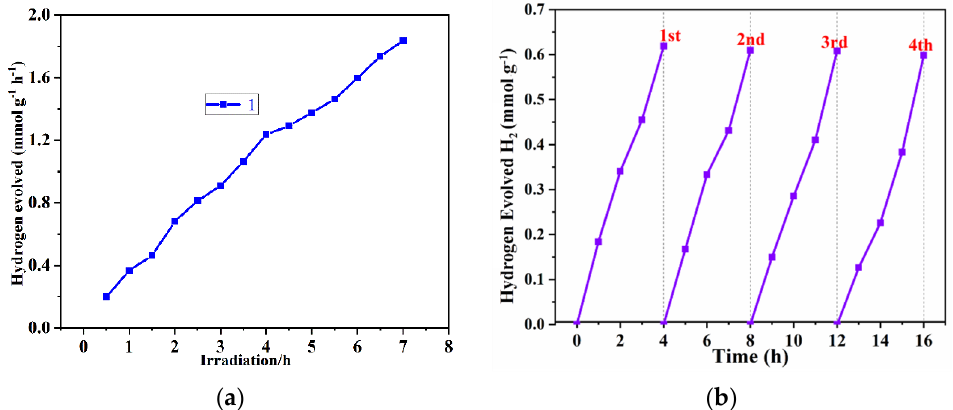
Figure 6. ( a ) The rate of hydrogen photogenerated over catalyst 1 (80 mg) in aqueous solutions (100 mL, pH = 11.5) containing Na 2 S and Na 2 SO 3 under visible light irradiation; ( b ) durability testing for the hydrogen generation of 1 , which was recycled from the reaction solution and used again under the same catalytic condition three times.